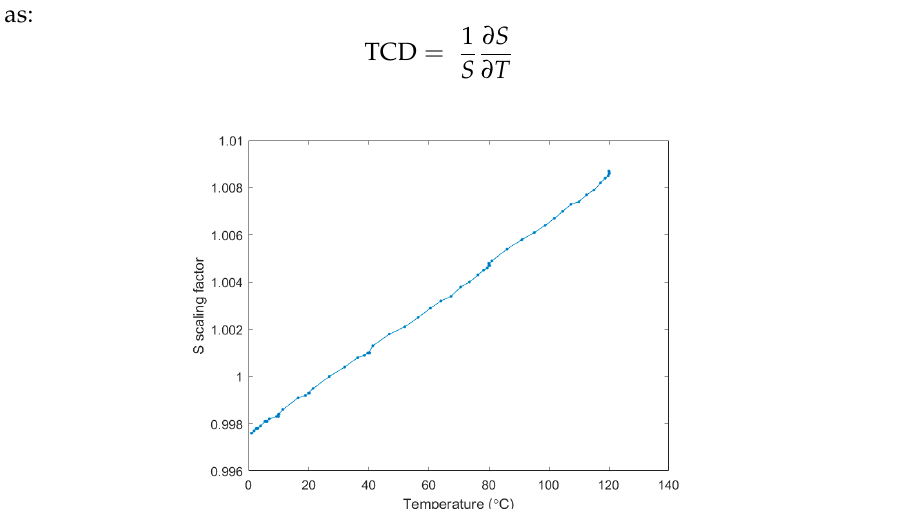
Figure 8. Measured sensor response versus temperature from 0 °C to 120 °C.